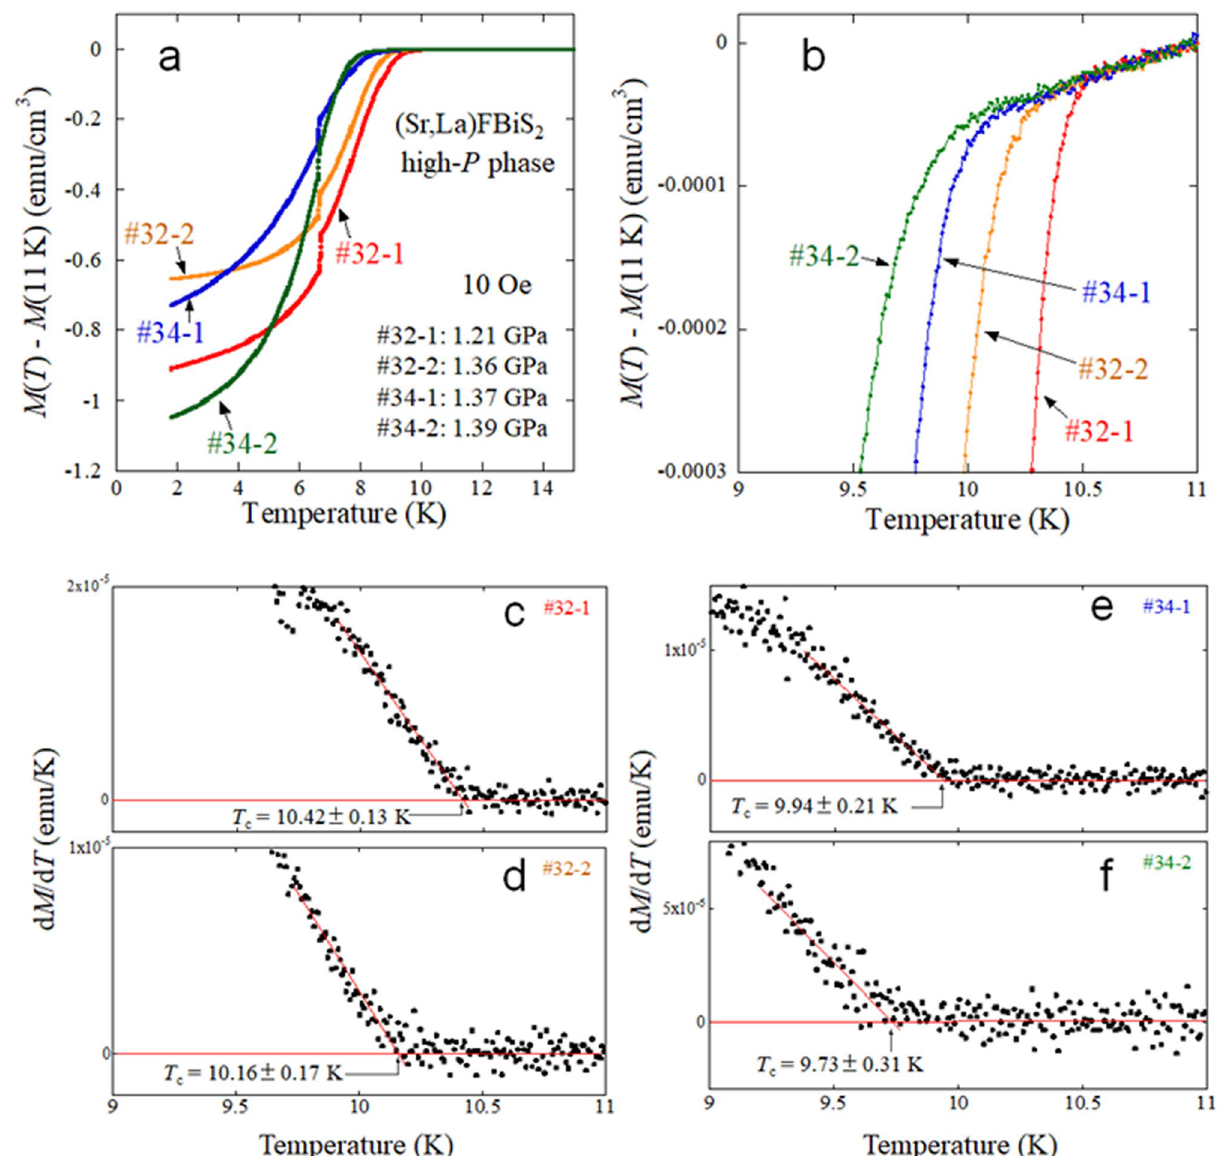
Figure 3. Estimation of T c onset from data of the temperature dependences of magnetisation for isotope samples of Sr 1− x La x FBiS 2 . ( a ) Temperature dependences of magnetisation for the high- P phases of 32-1, #32-2, #34-1, and #34-2. ( b ) Zoomed figure of ( a ) near the T c . ( c – f ) Temperature dependence of the temperature differential of magnetisation for #32-1, #32-2, #34-1, and #34-2. T c was estimated as the temperature at which linear fitting lines of just above and just below the onset of the transition cross as indicated by the red lines in the figures.